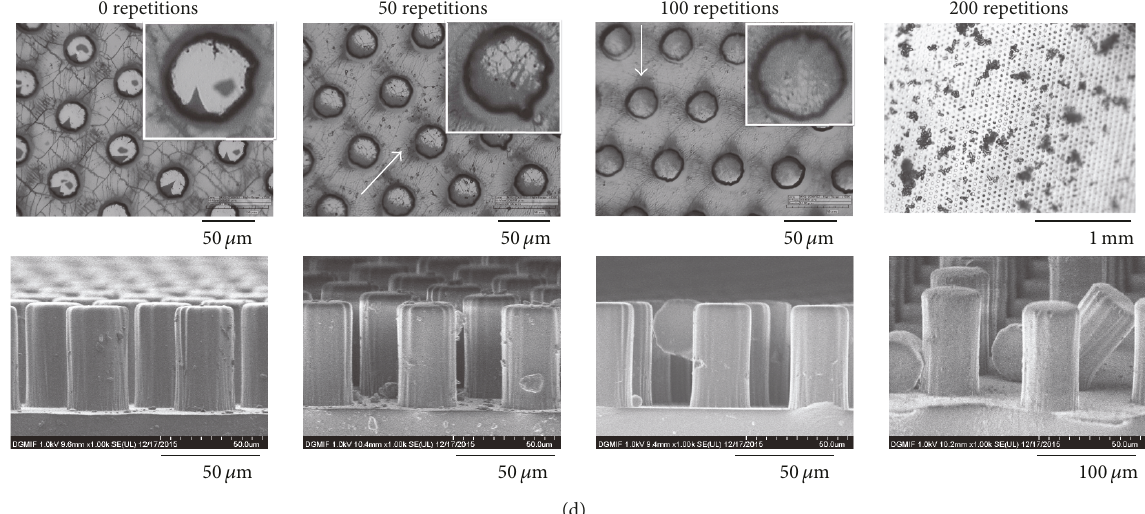
Figure 6: Changes of surface and structural integrity of SDAs (a) without metal coatings and with (b) indium coating, (c) zinc coating, and (d) gold coating (the inset shows the enlarged view of wear